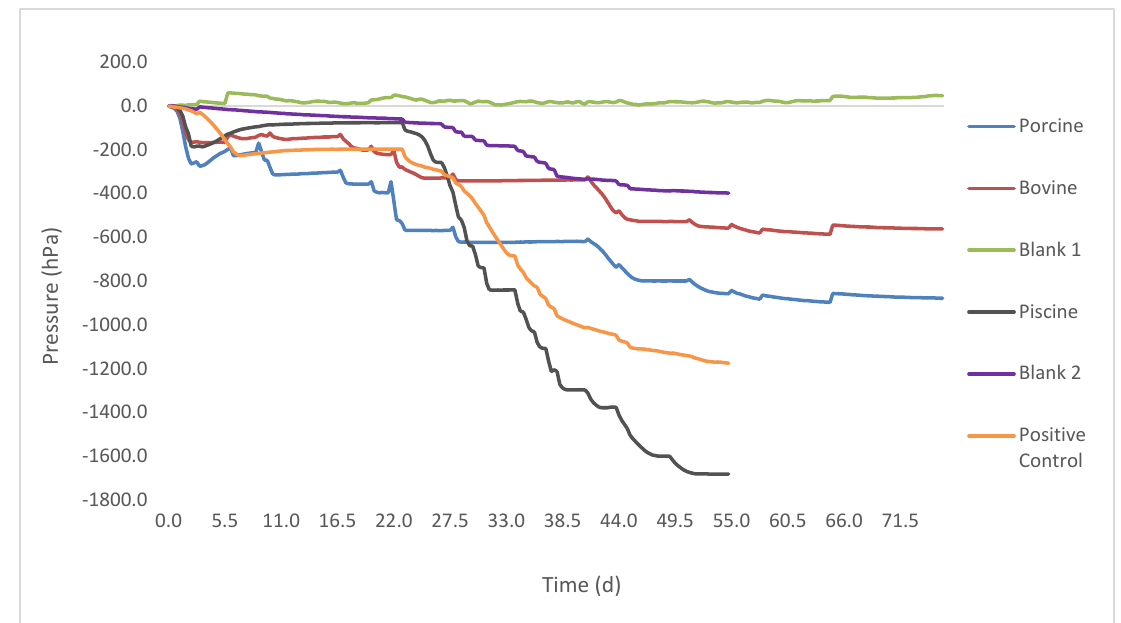
Figure 1. Pressure drops measured by Oxitop chambers of soil with bioplastic made from different gelatines. Blank 1 is a blank corresponding to porcine and bovine sample. Blank 2 is a blank corresponding to piscine and positive control, as they ran at two different times. Cellulose was used as positive control. (n = 3).